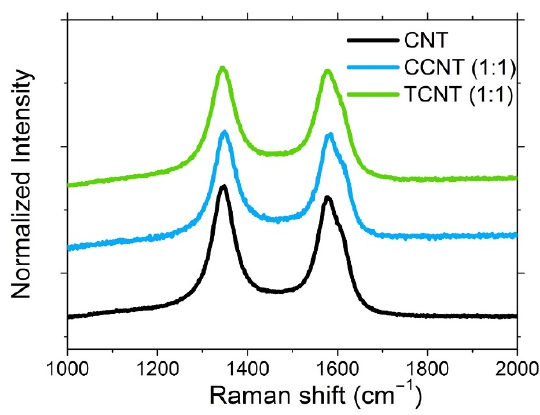
Figure 6. Raman spectra of CNTs, CCNTs, and TCNTs. Table 3. I D /I G ratios obtained from the Raman spectra of CNTs, CCNTs, and TCNTs.